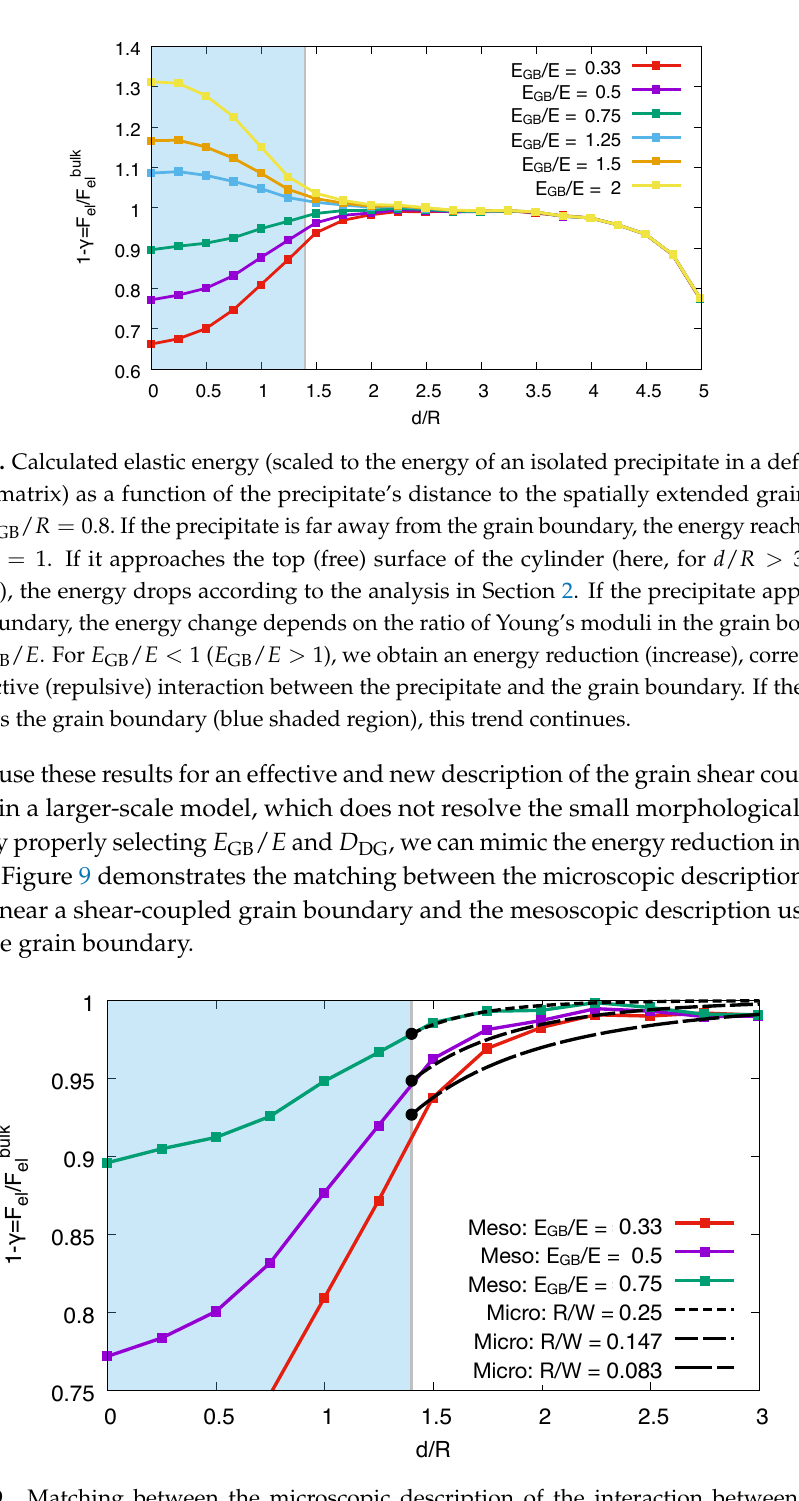
Figure 9. Matching between the microscopic description of the interaction between a coherent precipitate and a shear-coupled grain boundary (see Section 3) to a mesoscopic description with a finite width grain boundary layer. By the proper choice of the grain boundary thickness D GB and the elastic softening E GB / E , a reasonable matching can be achieved outside the grain boundary